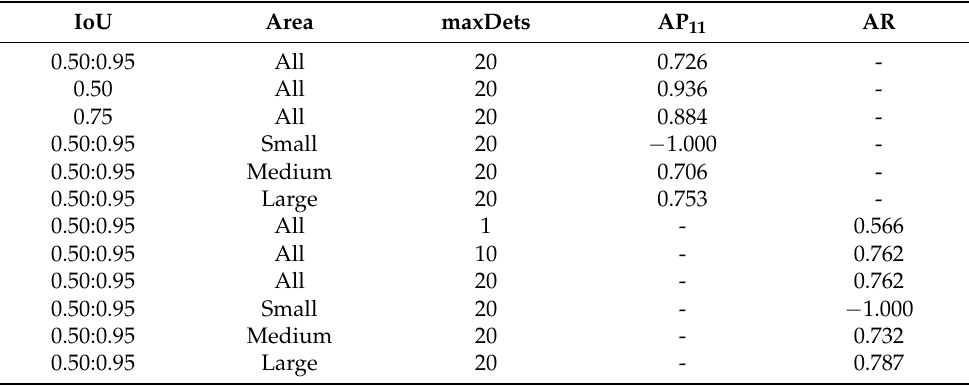
Table 3. Results on YOLOv4 using COCO API.